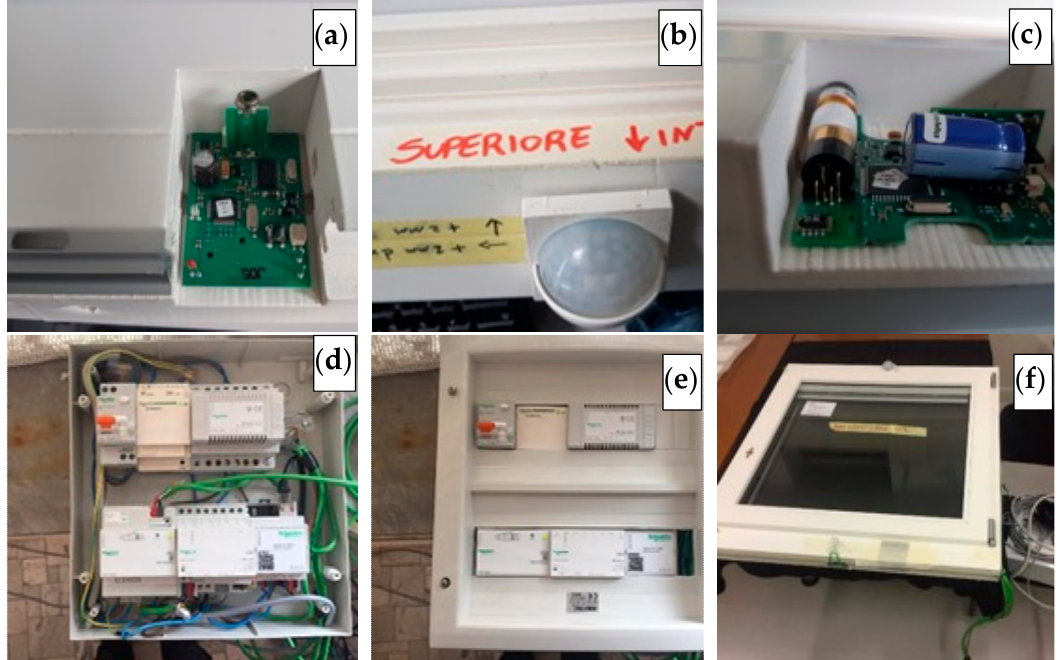
Figure 6. Sensors, cabling sequence, and installation of the window unit (Prototype 2, case study 1):